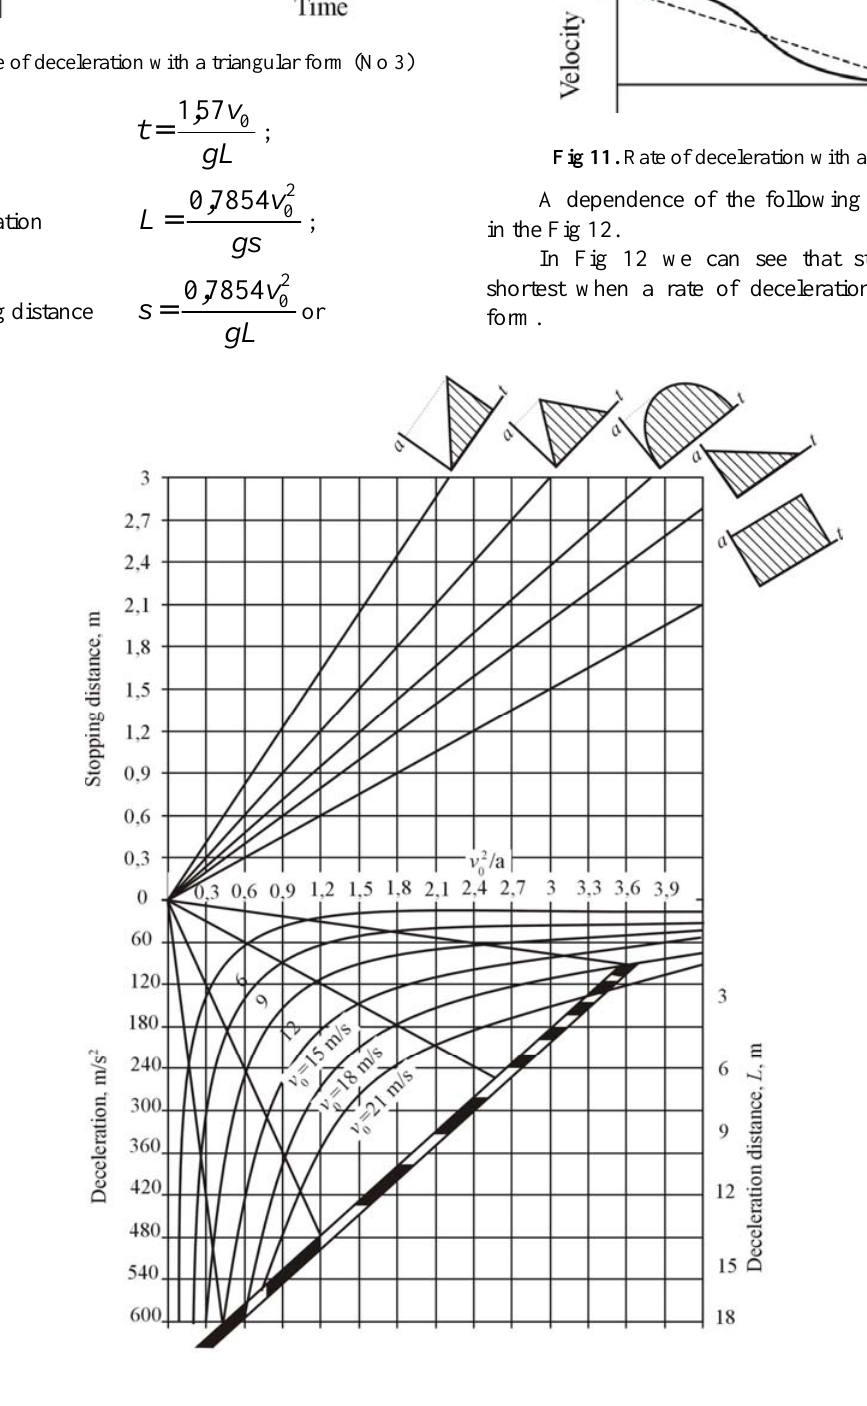
Fig 12. The dependences of the velocity, the deceleration and the distance on the